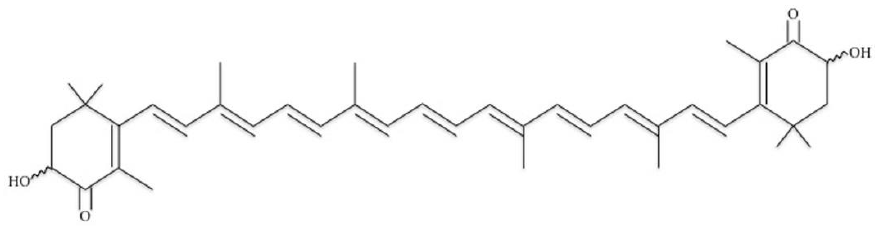
Figure 1. Chemical structure of the antioxidant